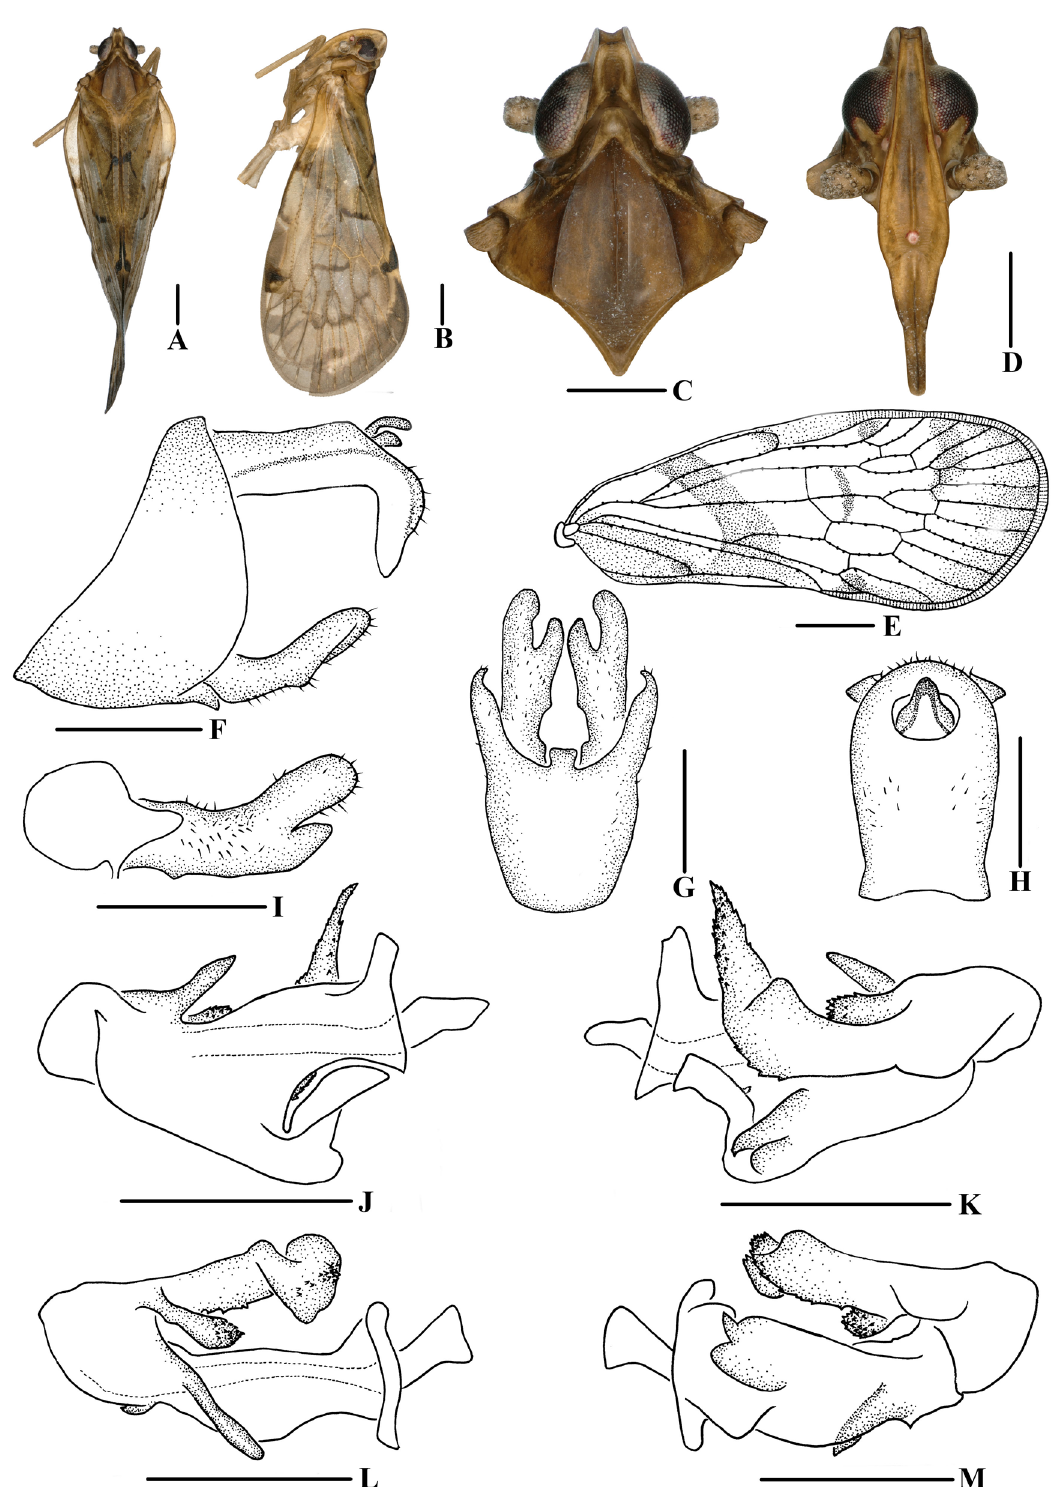
Fig. 3. Andes bifidus Wang, Zhi & Chen sp. nov., ♂. A . Dorsal view. B . Lateral view. C . Head and thorax, dorsal view. D . Face, ventral view. E . Forewing. F . Genitalia, lateral view. G . Pygofer and gonostyli, ventral view. H . Anal segment, dorsal view. I . Gonostyli, lateral view. J . Aedeagus, right side. K . Aedeagus, left side. L . Aedeagus, dorsal view. M . Aedeagus, ventral view. Scale bars: A–D, F–M = 0.5 mm; E = 1.0